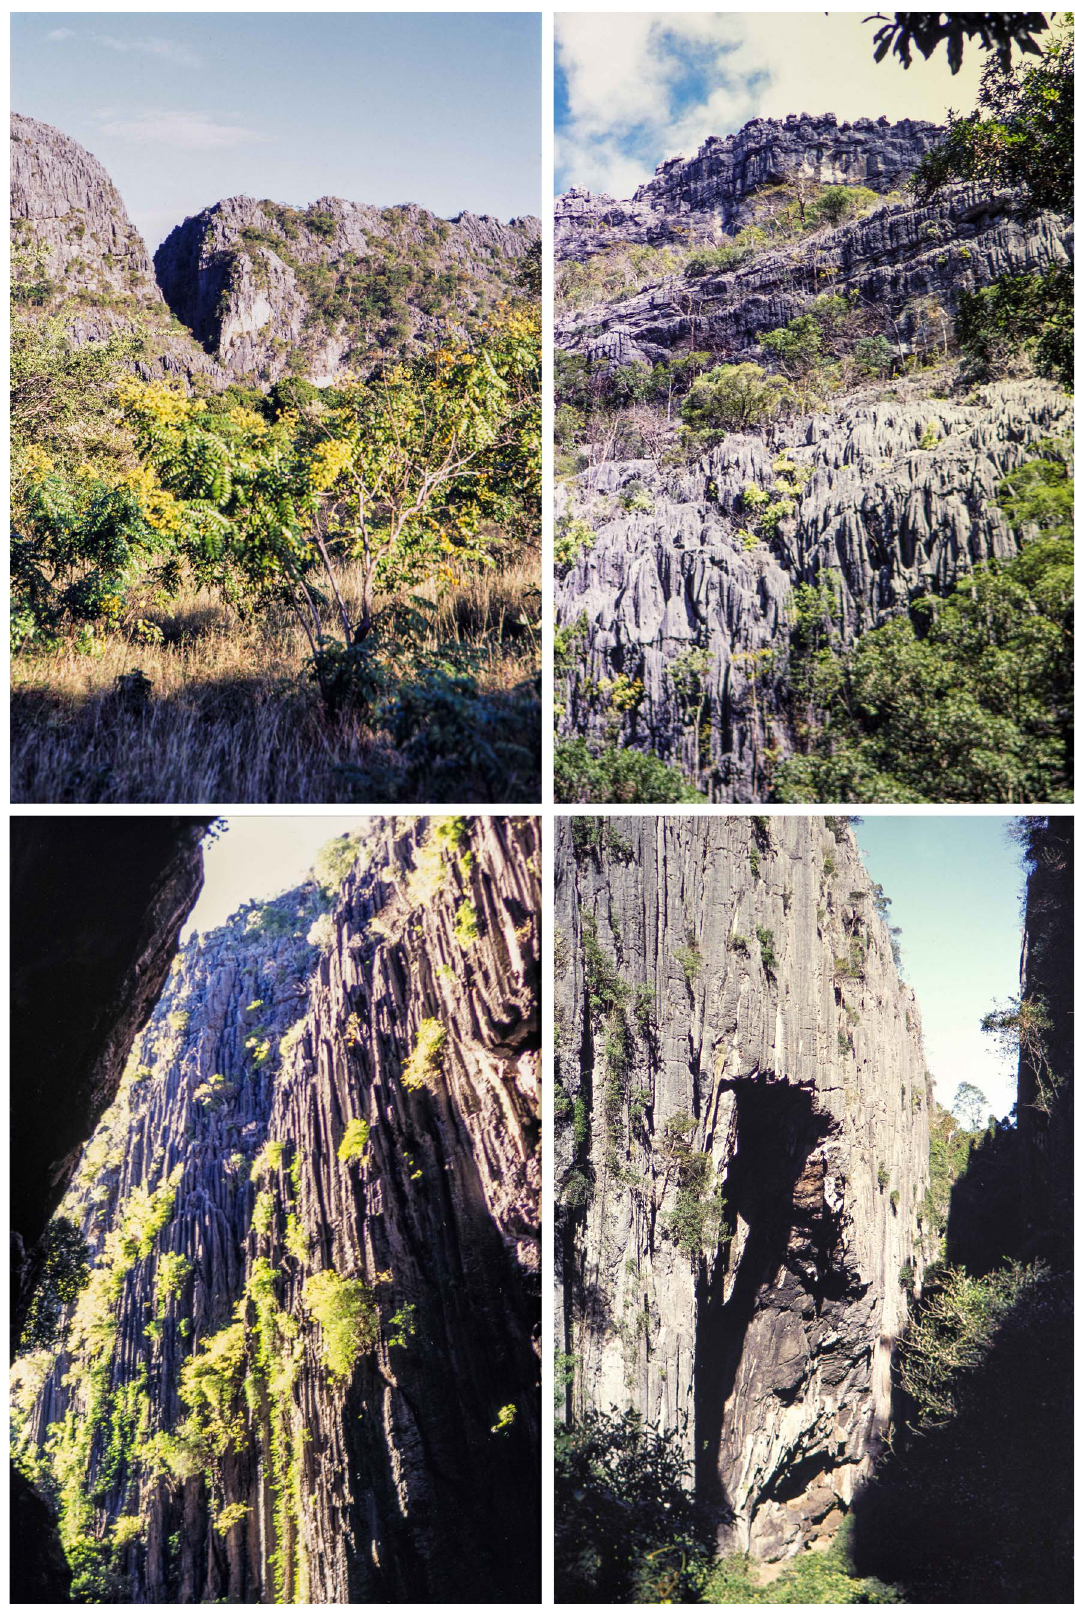
Figure 2. Four photos of the Tsingy of Ankarana taken in May 2003. Photos: Vincent